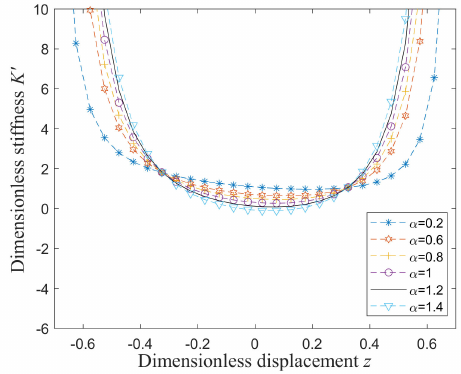
Figure 8. Dynamic stiffness curves of systems with the various values of α (z = H (cid:48) − x (cid:48)